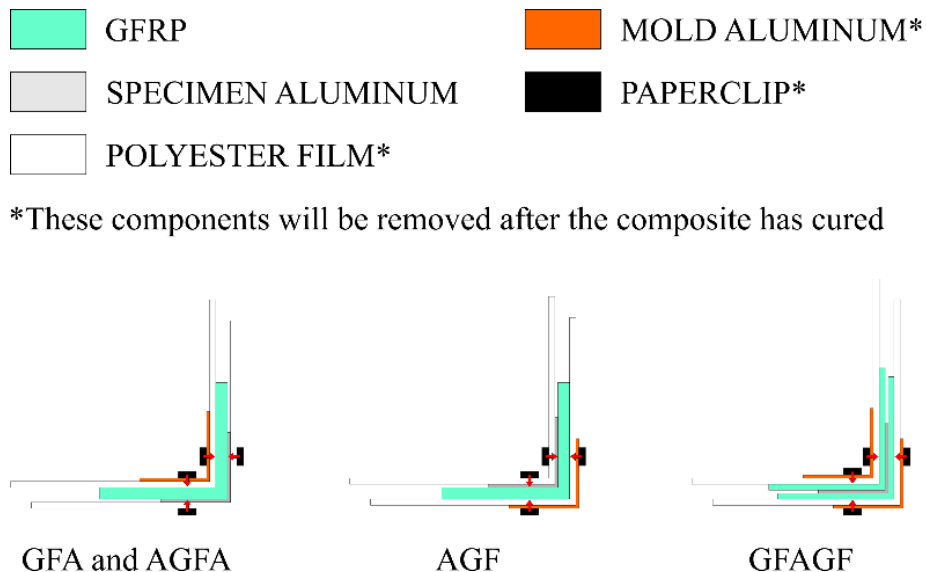
Figure 4. Schematic representation of the specimen curing setup.